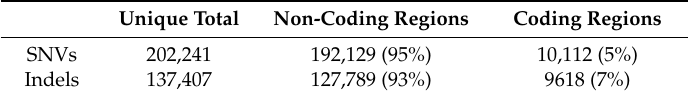
Table 2. Total number of unique, coding, and non-coding regions affected by single nucleotide variants (SNVs) and insertion-deletions (indels ).